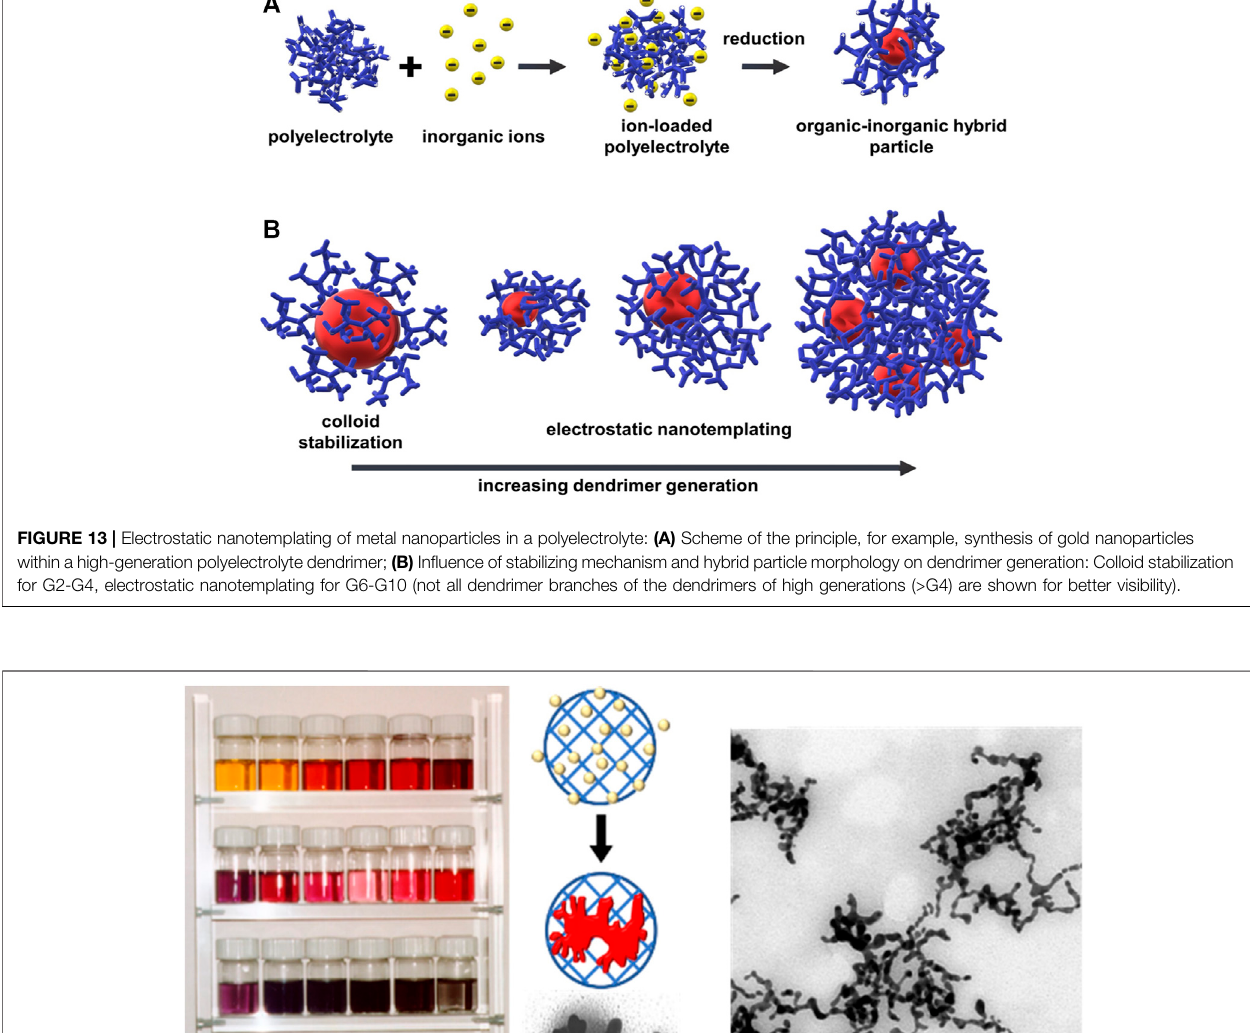
Frontiers in Chemistry |